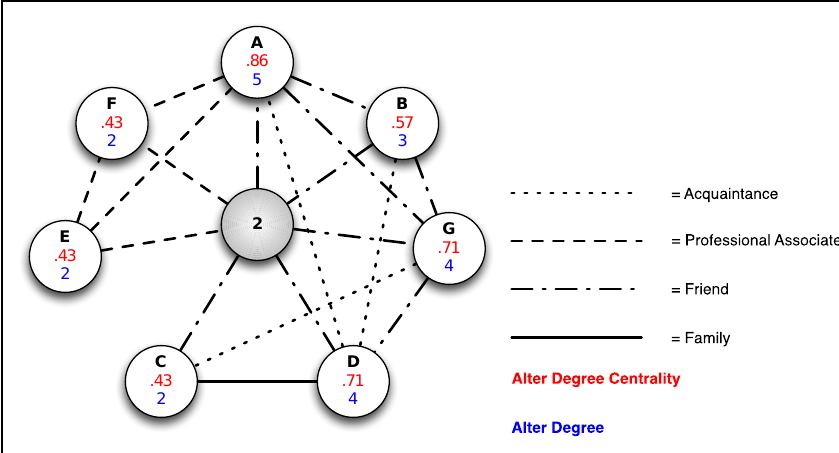
Figure 4. Diverse Farmer Advice Network (Made Up of All Four Types of Ties)